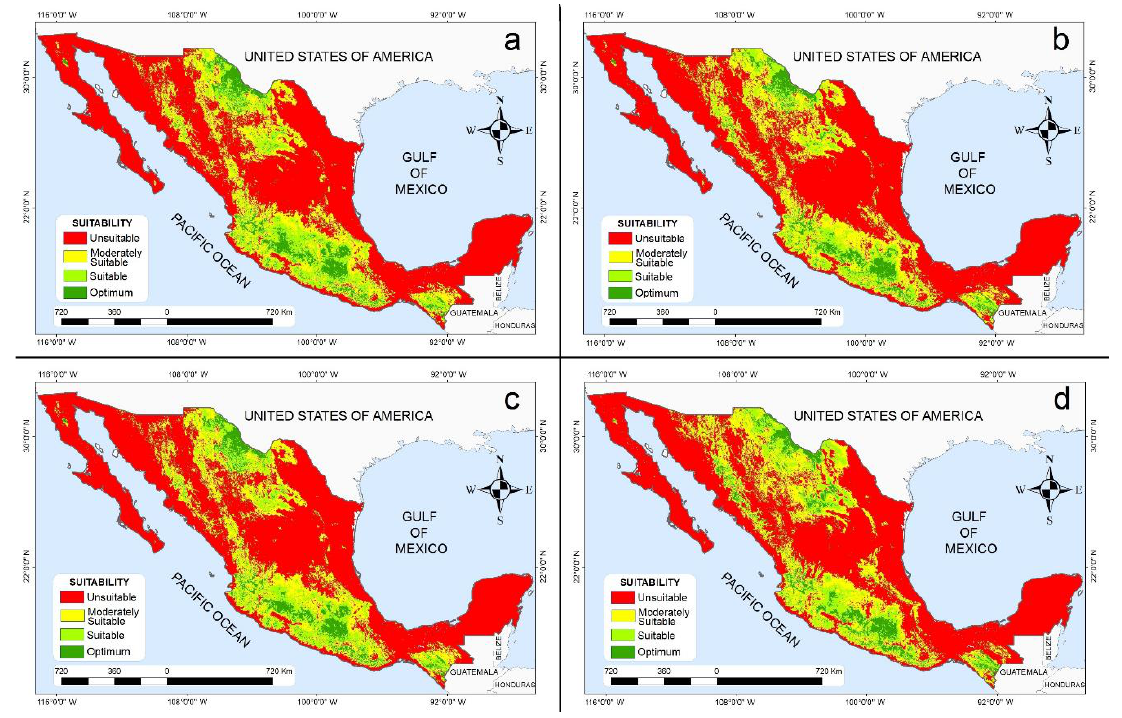
Figure 3. ( a ) HADGEM2-ES 2050 RCP 2.6, ( b ) HADGEM2-ES 2050 RCP 8.5, ( c ) HADGEM2-ES 2070 RCP 2.6 y, and ( d ) HADGEM2-ES 2070 RCP 8.5.